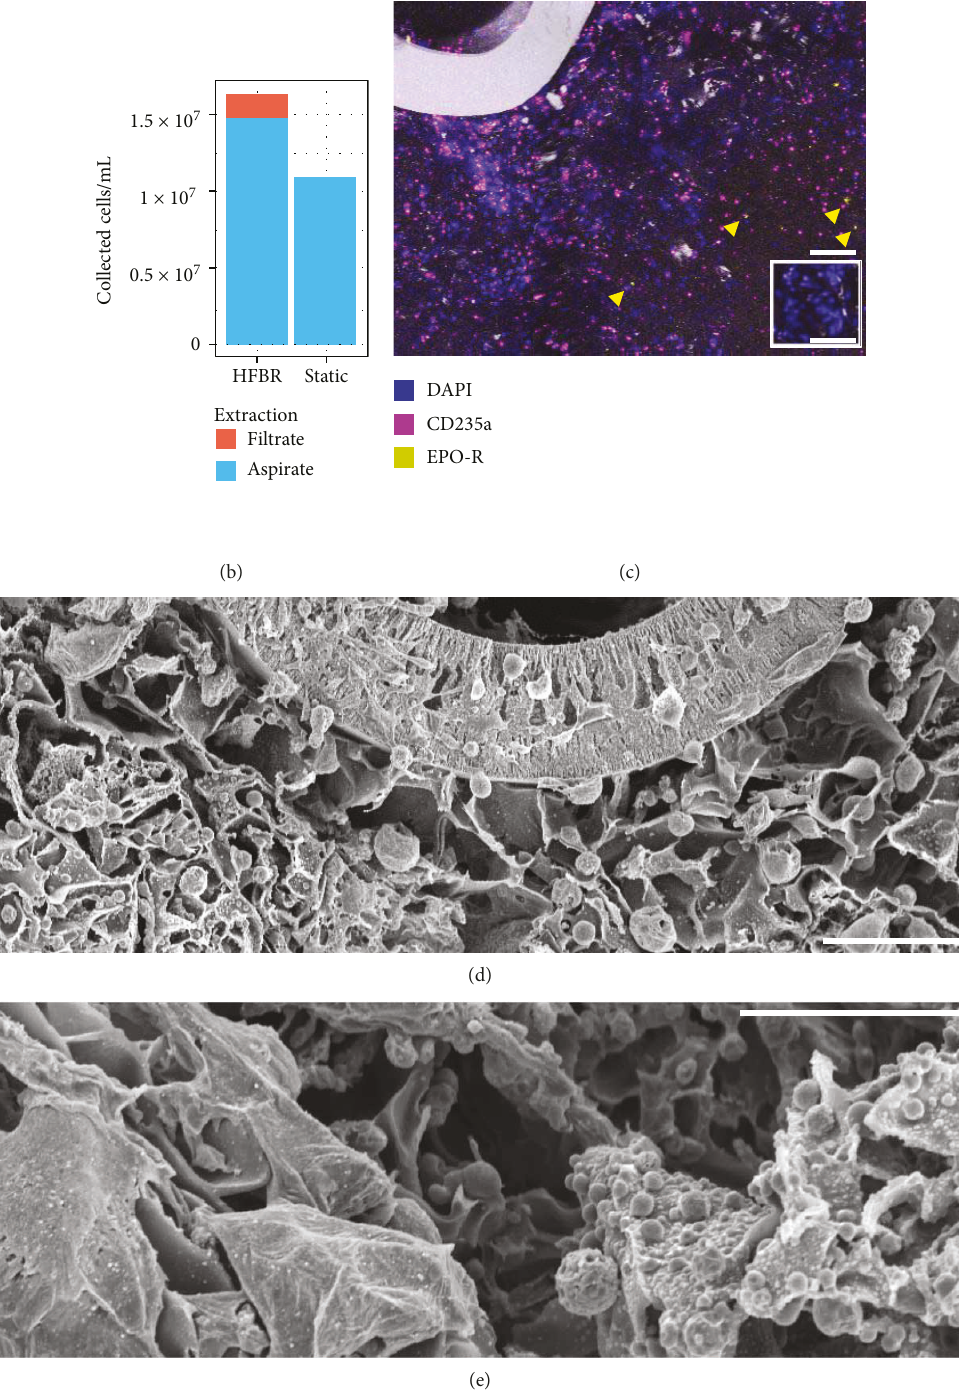
Figure 6: Long-term 3D perfusion hollow fi bre bioreactor culture. (a) Measurements of glucose (top), lactate (middle), and pH (bottom) measured at HFBR in fl uent, e ffl uent, and static supernatant every 2 days during culture. (b) Comparison of cells per mL of culture volume extracted at day 21 within perfused HFBR versus unperfused, static sca ff old cultures. (c) Confocal microscope image of HFBR cross section at day 21 detecting CD235a (pink), EPO-R (yellow, indicated by yellow arrowheads), nuclei (DAPI; blue), and laser re fl ection (grey) (100 μ m scale bar). SEM images of HFBR cross sections at day 21 of culture highlighting diverse cell morphologies near HFs (d, 200 μ m scale bar) or further into the bulk HFBR sca ff old (e, 100 μ m scale